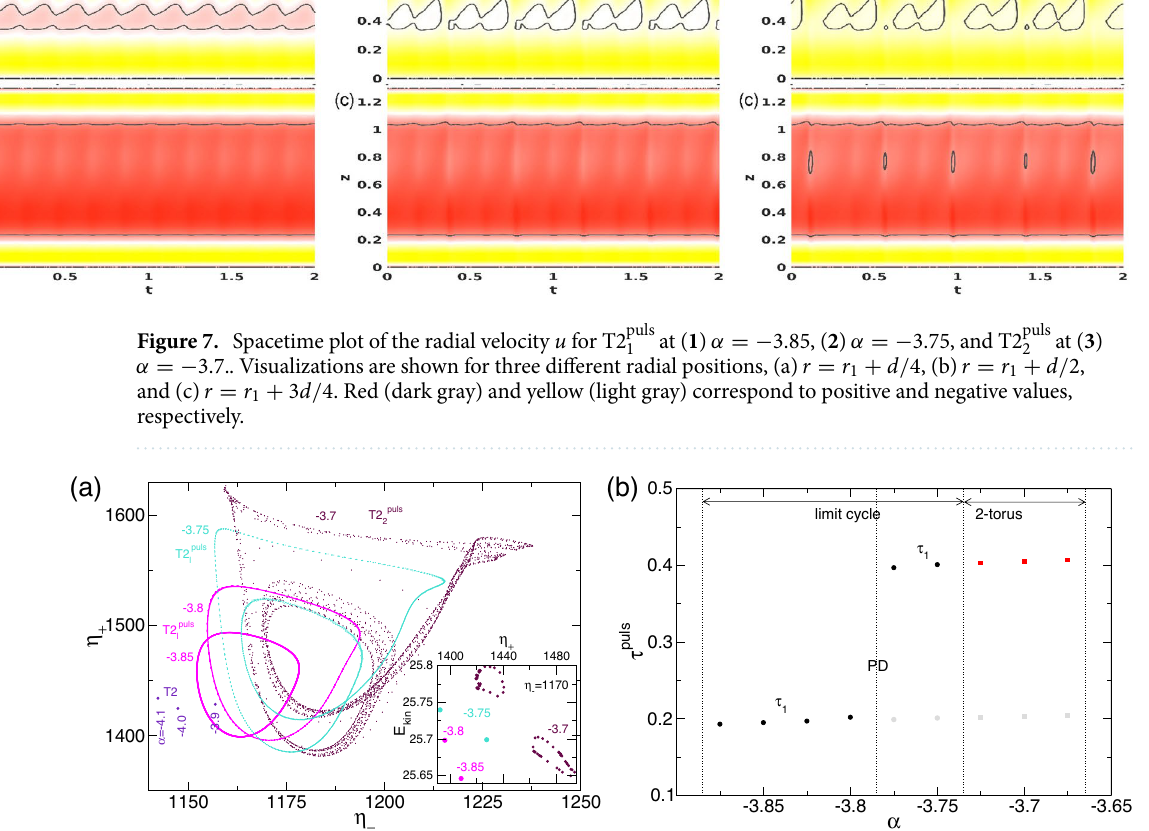
puls puls α , as 1 and T2 2 states for ) , with +